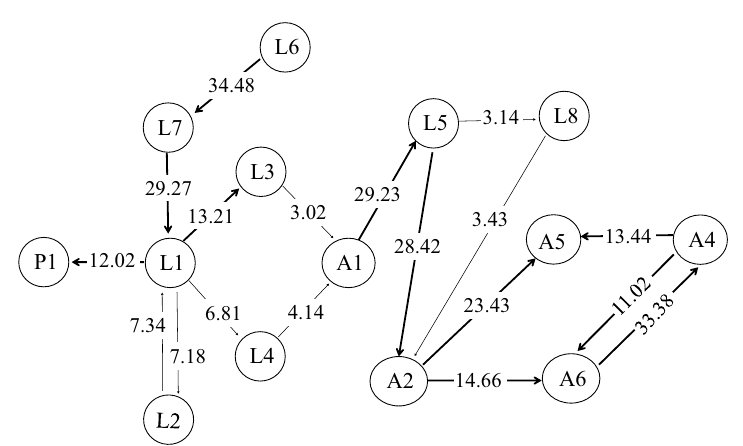
Fig. 9 Behavioral patterns of the AR